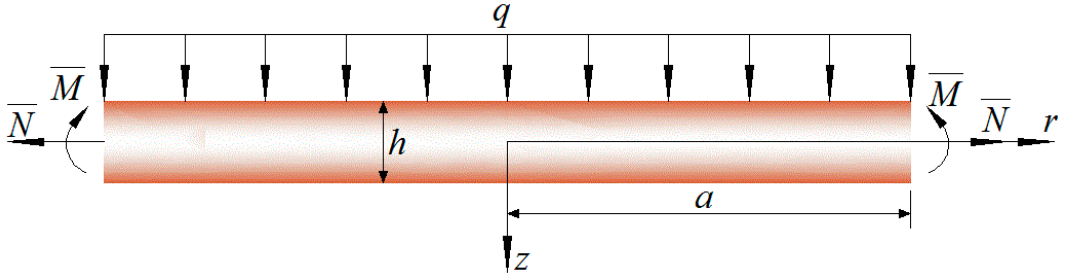
Figure 1. Sketch of a functionally graded piezoelectric circular plate.